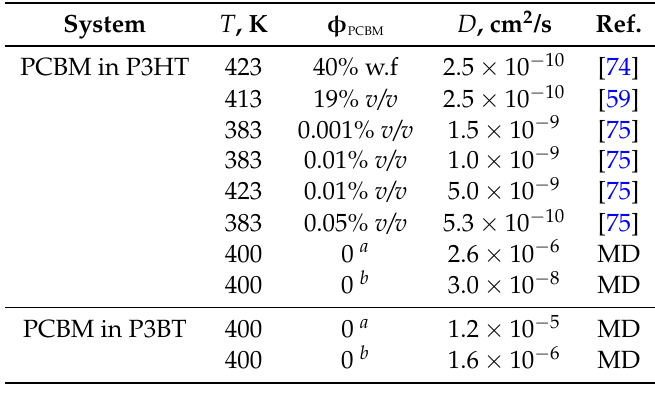
Table 1. Diffusion coefficients of PCBM in its blend with P3HT or P3BT obtained in previous studies at various temperatures T and finite concentrations of PCBM φ from MD simulations at infinite dilution. Here, w.f. stands for weight fraction and v/v indicates the volume fraction of a component per total volume. φ